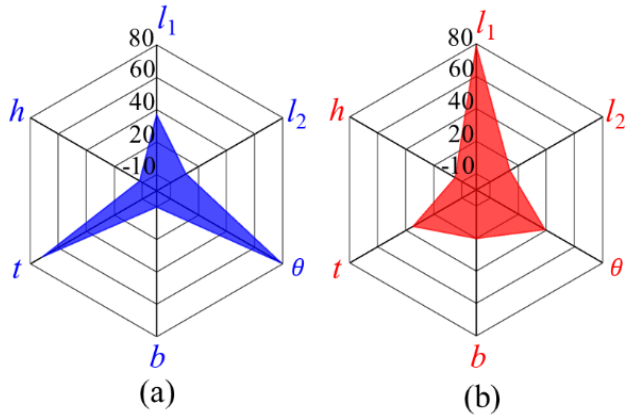
Figure 5. Parameter sensitivity analysis: ( a ) sensitivity of the displacement magnification; ( b ) sensitivity of the input stiffness.